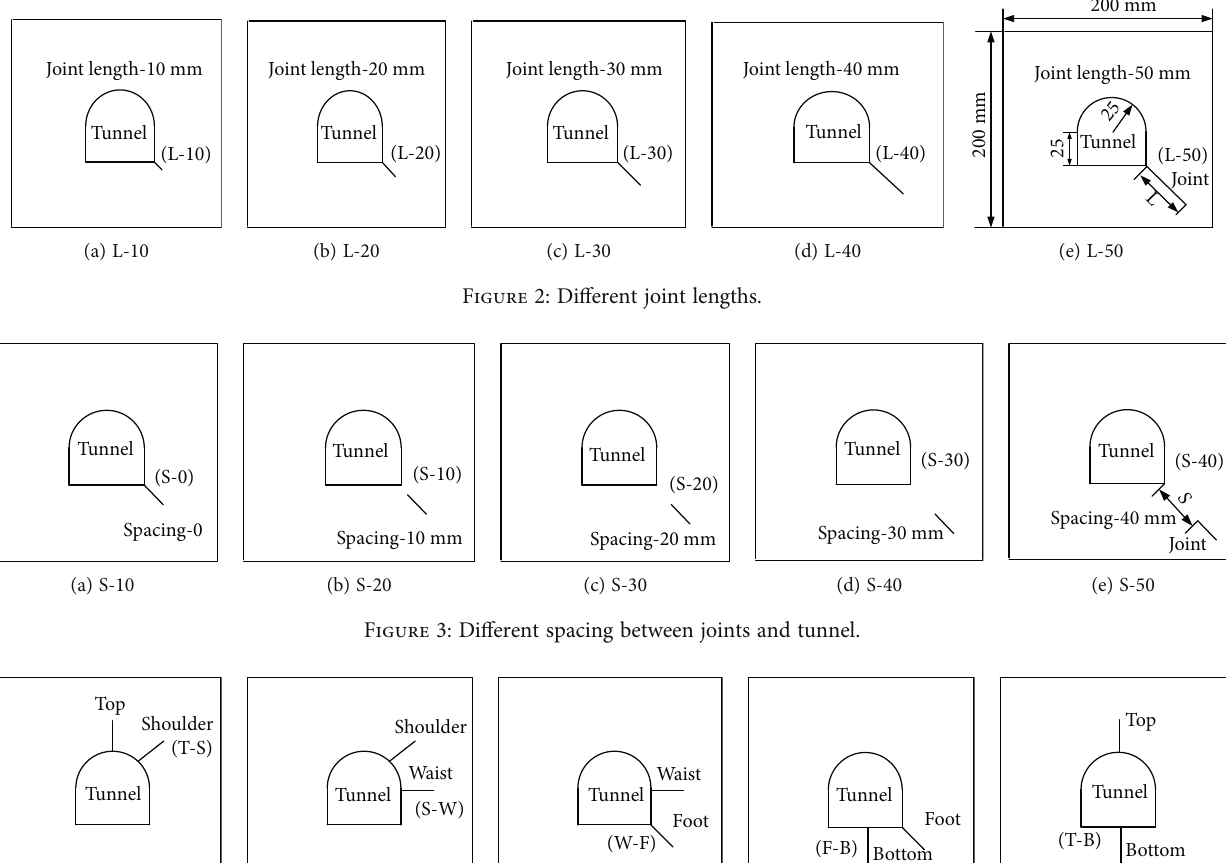
Figure 4: Double-joint location.